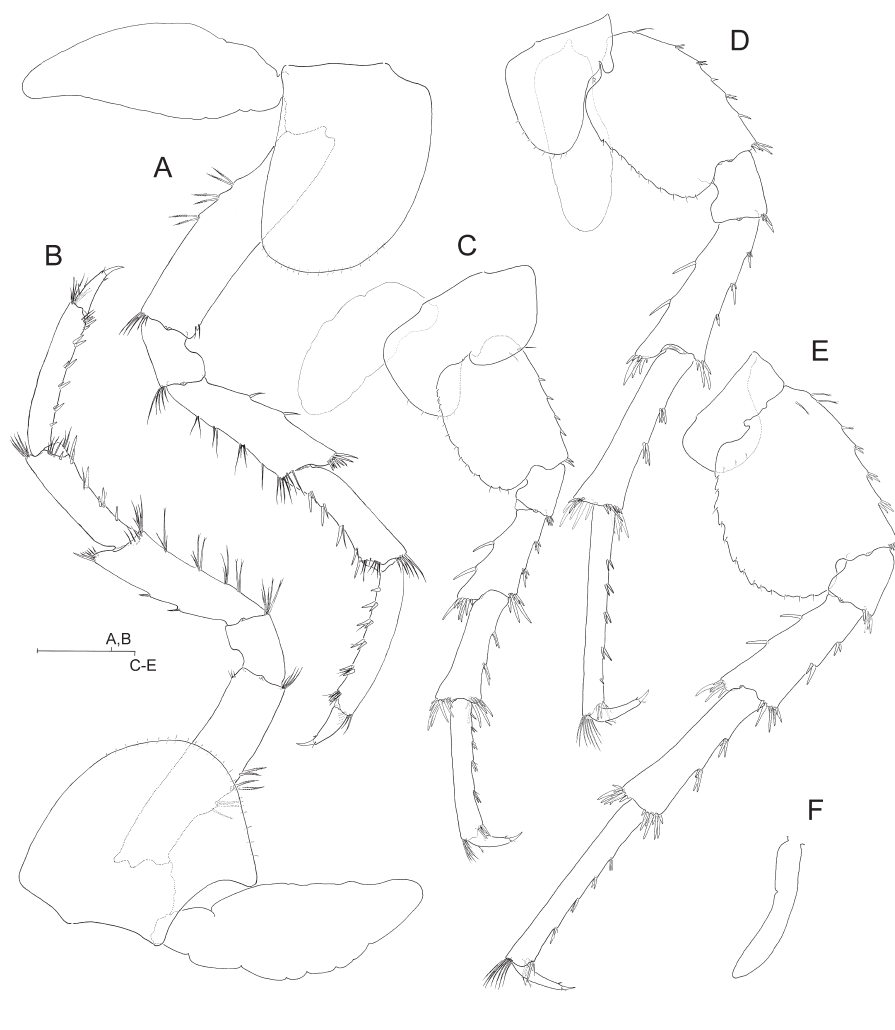
Figure 4. Hyalella cajasi sp. n., male. A right pereiopod 3, lateral B right pereiopod 4, lateral C right pereiopod 5, lateral, coxal gill omitted D right pereiopod 6, lateral, coxal gill omitted E left pereiopod 7, medial F left sternal gill on sternite of pereionite VII. Scale bars: 0.5 mm.